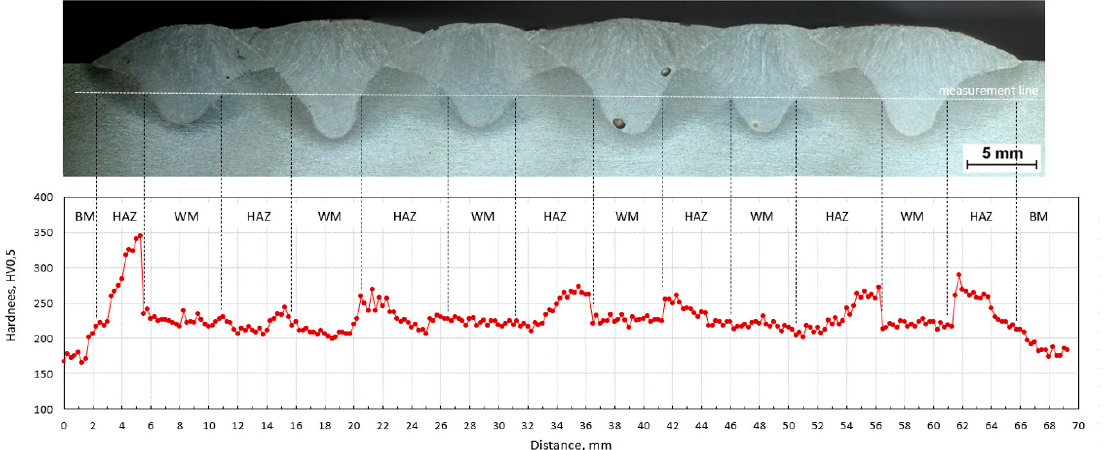
Figure 19. Hardness HV 0.5 distribution in plate C; BM—base material, WM—weld metal, HAZ—heat-affected zone.